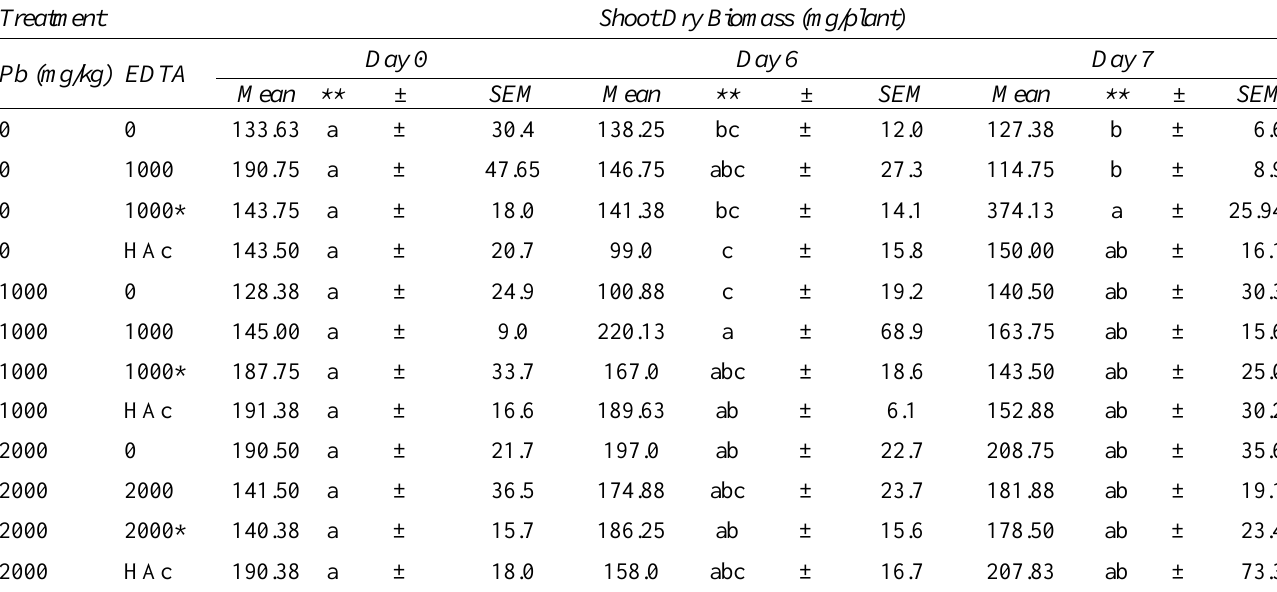
) ] six weeks after 3 2